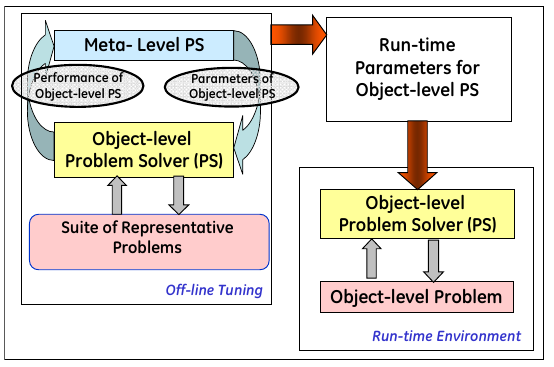
Fig. 2. Schematic of Offline Meta-Heuristics (adapted from reference 14).